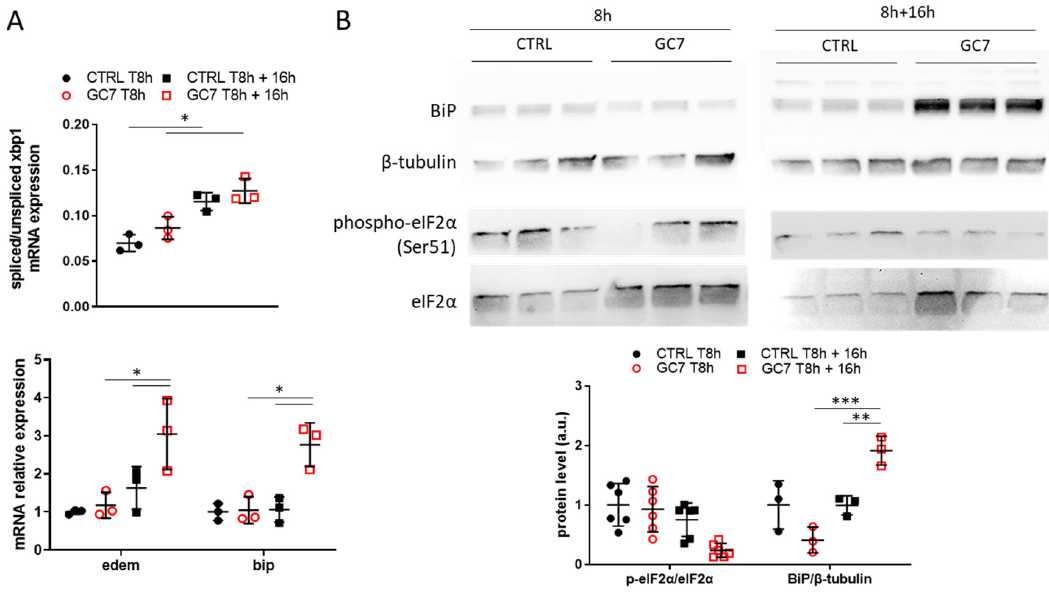
Figure 8. GC7 preconditioning effect on ER stress. PCT cells pretreated for 8 h either with a vehicle or with 30 μ M GC7. At the end of treatment or 16 h later cells were either lysed for ( A ) mRNA or ( B ) protein expression analysis. ( A ) Scatter plot representation of individual values along with mean ± SD (n = 3) for the ratio of spliced/unspliced xbp1 mRNA and the relative expressions of edem and bip . ( B ) Representative western blots of BiP, β‐ tubulin and eIF2 α (total and phosphorylated on Ser51 site) protein levels and the scatter plot representation of normalized individual values along with mean ± SD, n = 3. * = p ≤ 0.01; ** = p ≤ 0.001; *** = p ≤ 0.0001.